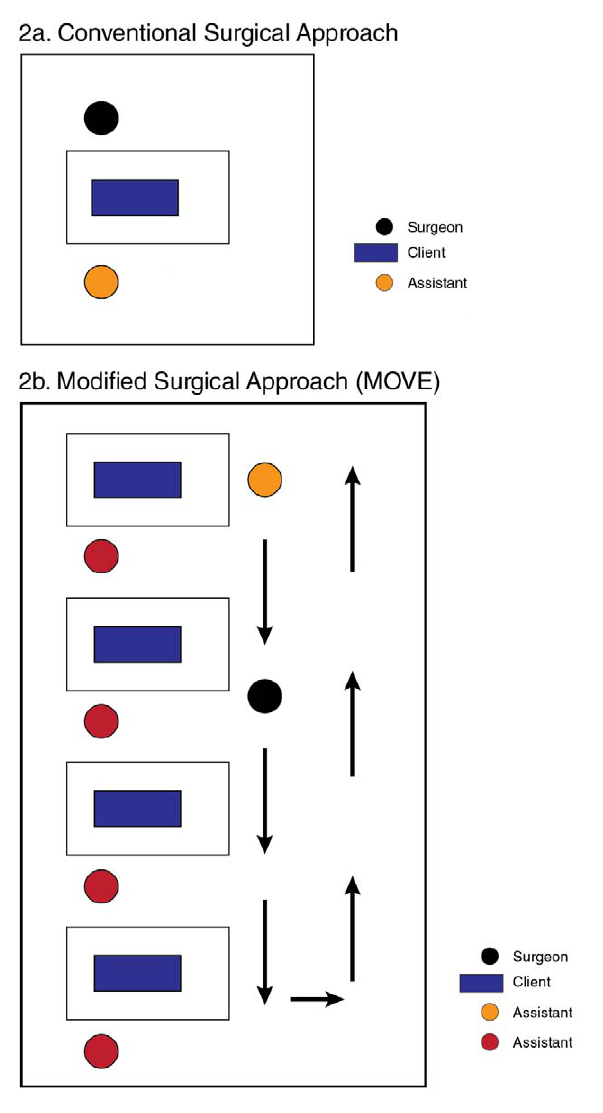
Figure 2. Conventional and modified surgical approaches to MC provision. (A) The conventional approach to MC provision requires 20–30 minutes per procedure and allows only two surgeries per hour (ten surgeries per day) because of the doctors ‘‘downtime’’ between procedures. (B) With the modified surgical approach to MC provision (MOVE), each procedure still takes 20–30 minutes, but task sharing reduces the doctor’s time to 6–8 minutes per procedure, which allows eight surgeries per hour (40 surgeries per